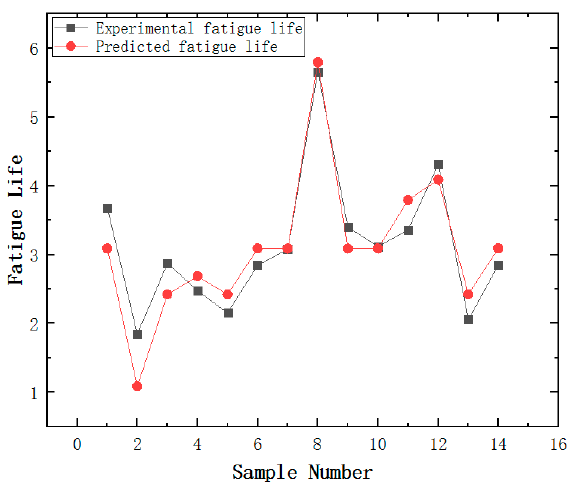
Figure 6. Comparison of experimental value and predicted value.